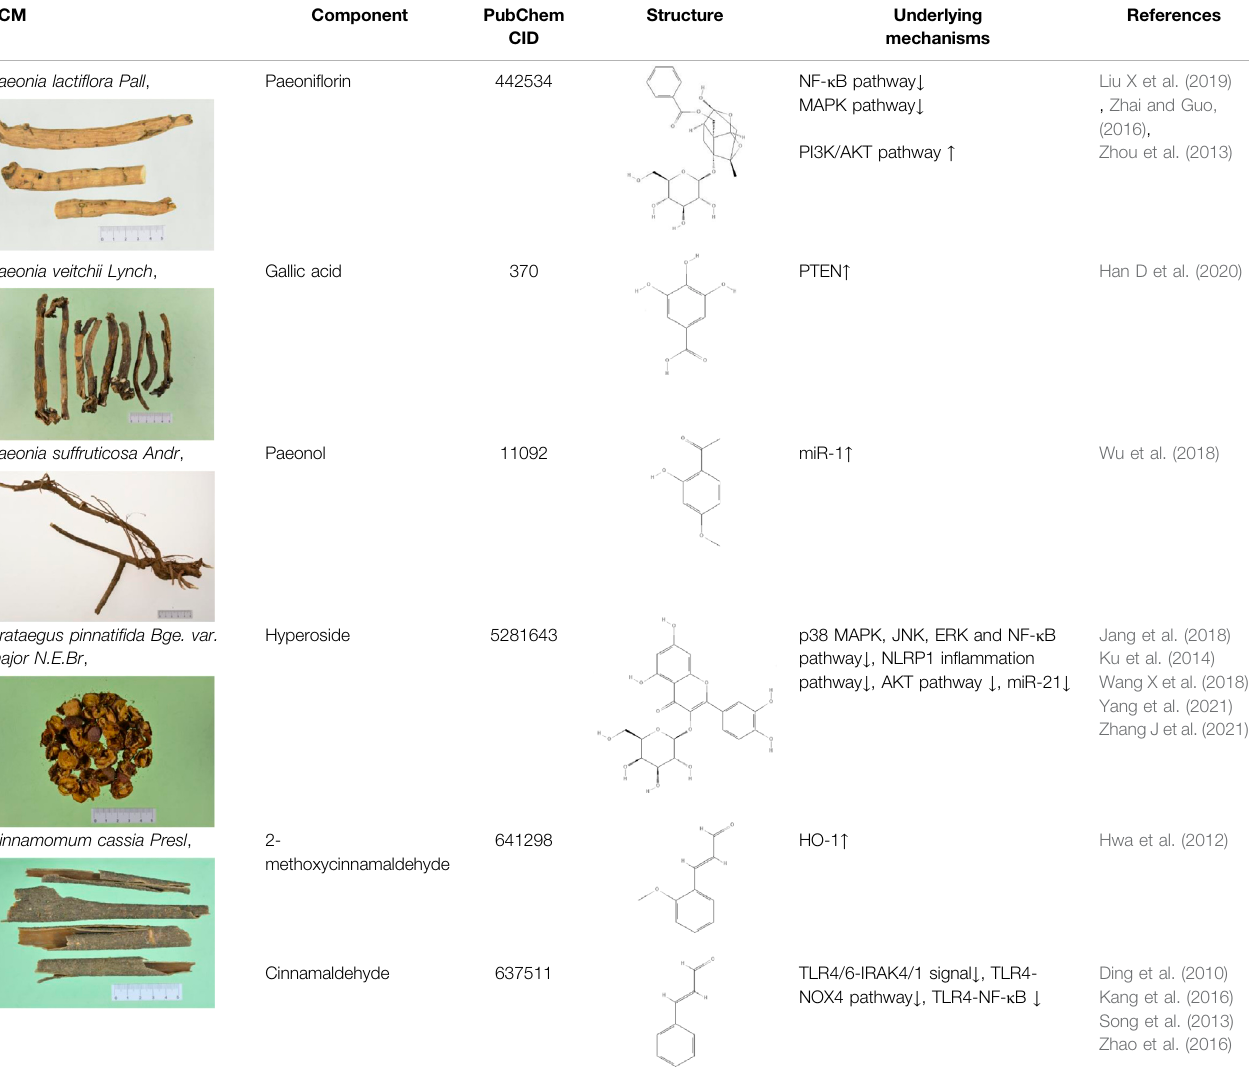
TABLE 5 | The mechanisms of TCM in improving in fl